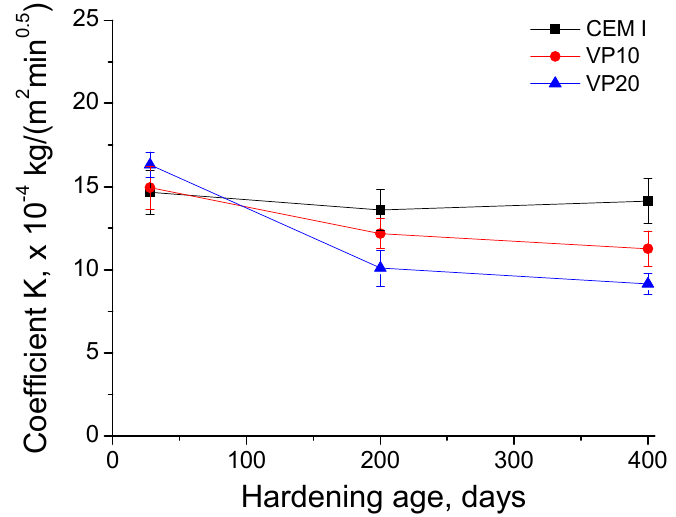
Figure 13. Capillary suction coefficient (K) for the mortars studied.